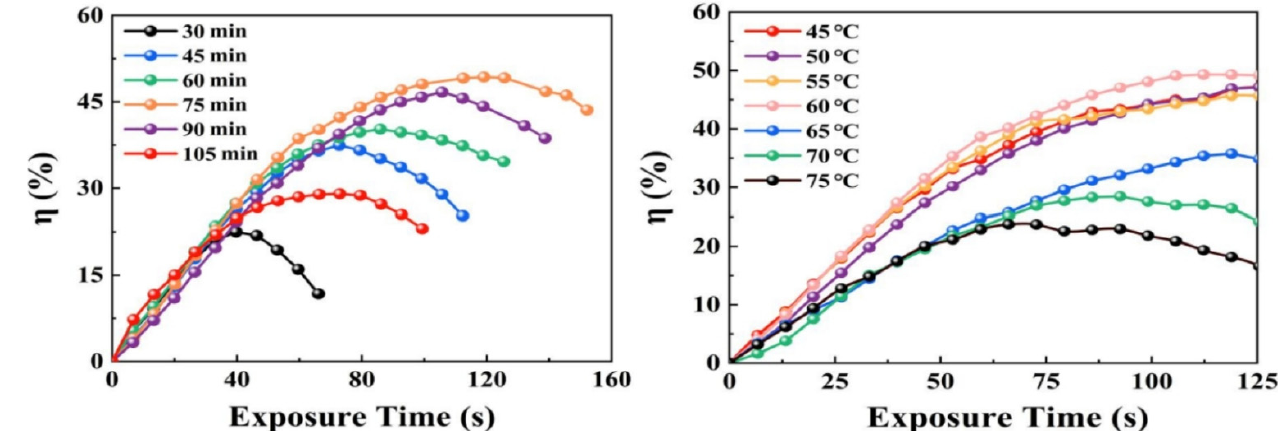
Figure 19. Exposure-time-dependent diffraction efficiency of PQ/PMMA with different stirring times and at different temperatures [99] .